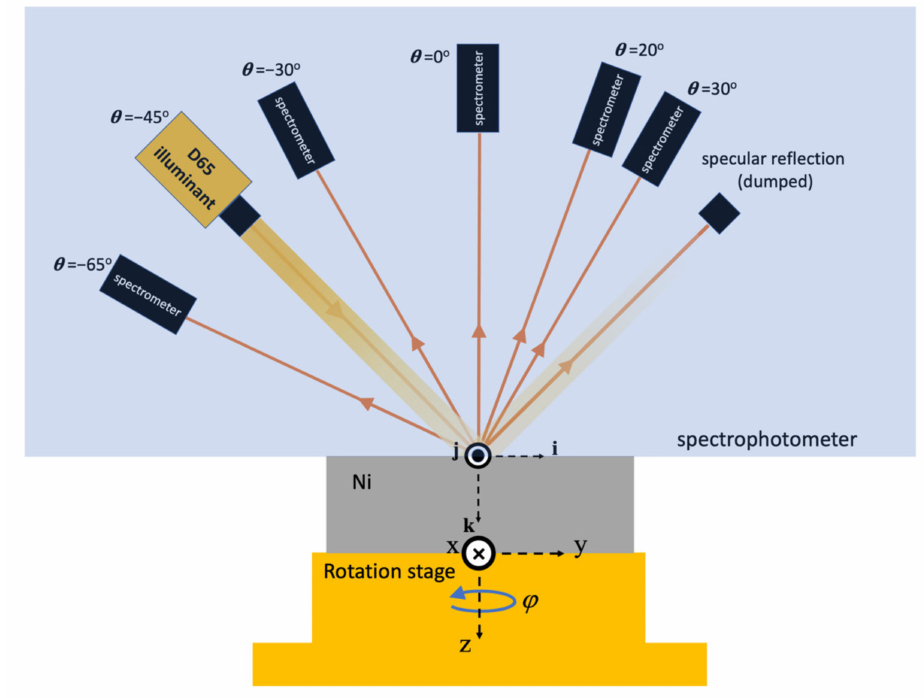
Figure 2. Configuration of the colorimetric measurements from the polished Ni, UD- and OD-LSFLs on Ni by using a spectrophotometer with detection angles of 30 ◦ , 20 ◦ , 0 ◦ , − 30 ◦ , and − 65 ◦ . The ijk axes are the space-fixed frame with their origin located in the center of the D65 illuminant spot at the sample surface. The xyz axes are the body-fixed frame, rotating with the Ni sample, and the sample rotation about the z -axis is indicated by ϕ , defined as 0 ◦ when the x -direction is antiparallel to the j